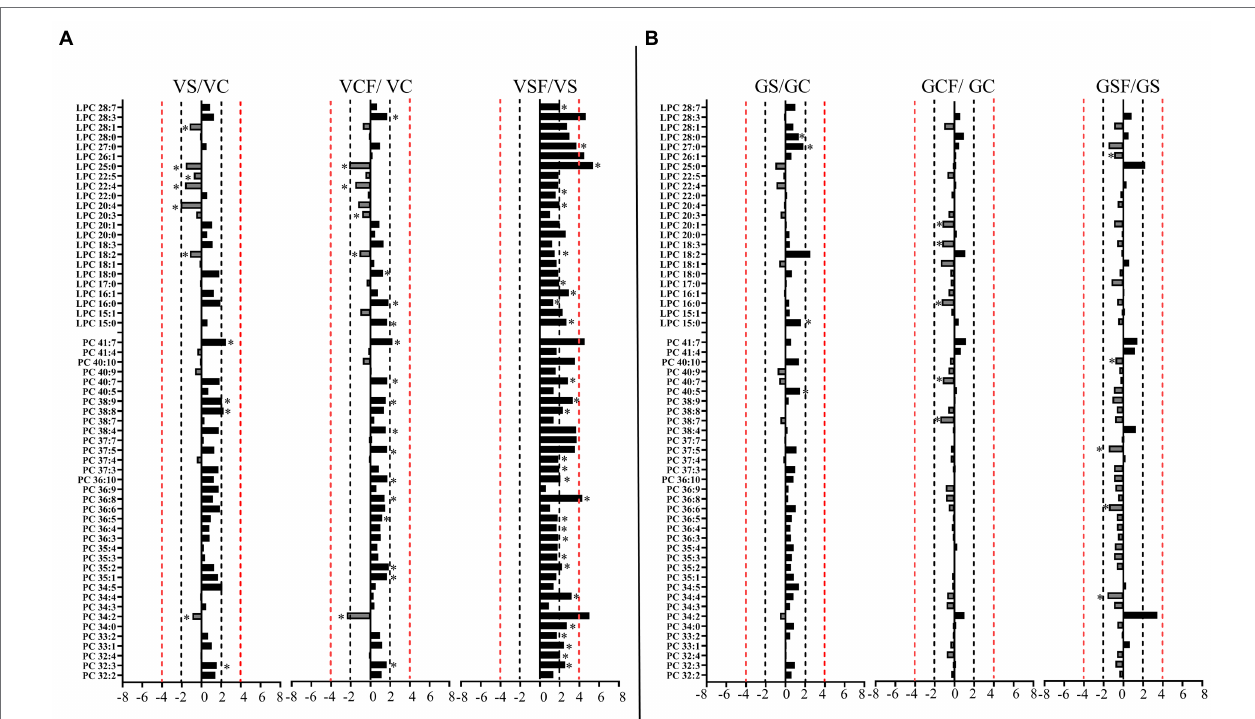
FIGURE 7 | Logarithmic ratios of representative phosphatidylcholine (PC) and lysophosphatidylcholine (LPC) content in roots of barley cv. Vlamingh (V) given as (A) and cv. Gairdner (G) given as (B) , showing three comparisons—salt grown (200 mM NaCl) vs. control grown ( VS /VC and GS/GC); control with fungus vs. control grown (VCF/VC and GCF/GC); salt and fungus grown vs. salt grown (VSF/ VS and GSF/GS). An asterisk ( * ) indicates that the values are significantly different ( p < 0.05, FDR). A black dashed line indicates a 2-fold change threshold, whereas a red dashed line indicates a 4-fold change threshold. All treatments included a total of six replicates ( n =